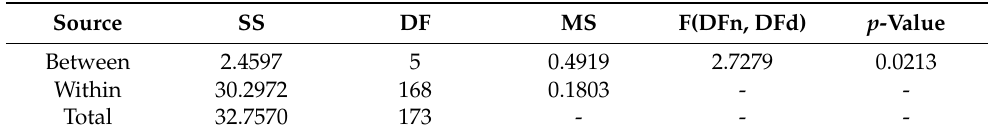
Table 5. ANOVA test results; SS: Sum of Squares; DF: Degrees of Freedom; MS: Mean Squared; F: F ratio; p -value: significance